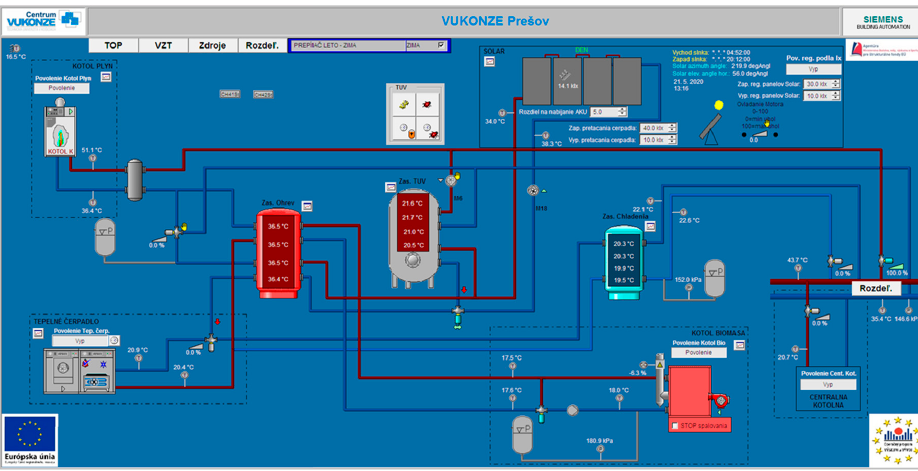
Figure 2. Control system based on Siemens Desigo